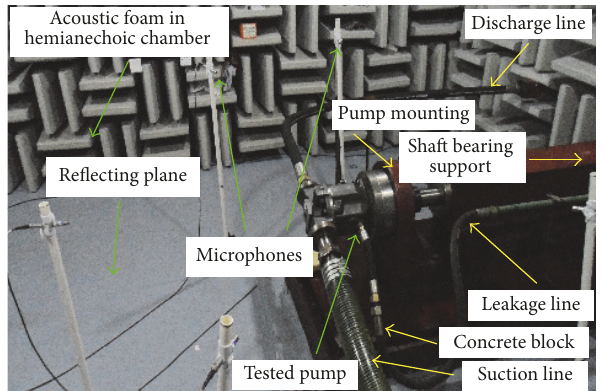
Figure 14: The tested pump in the hemianechoic chamber.